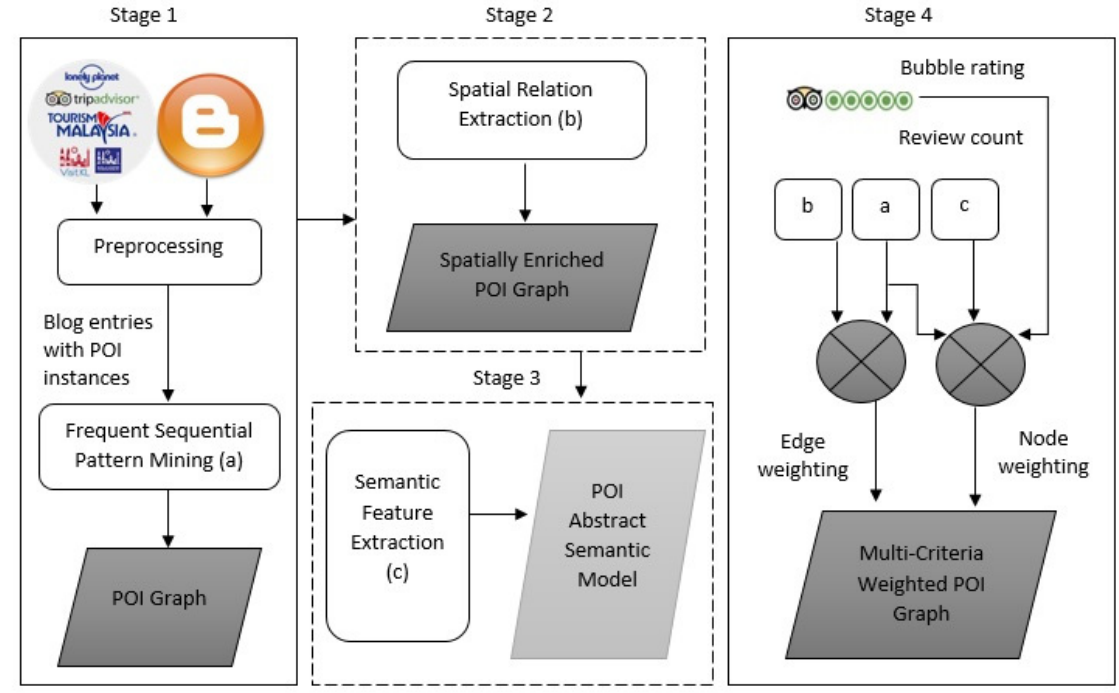
Figure 1. Proposed methodology to construct a multi-criteria-weighted points of interest graph (POI graph).